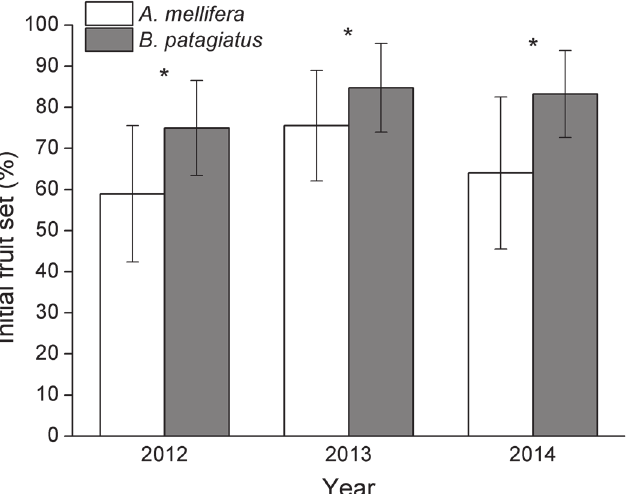
Fig 6. Initial fruit set of peach under greenhouse conditions. Initial fruit set (Mean ± SD) from flowers pollinated by A . mellifera and B . patagiatus . Within each year, branches from all plots are combined here. Single asterisks indicate significant difference at P < 0.05 by the group t -test.